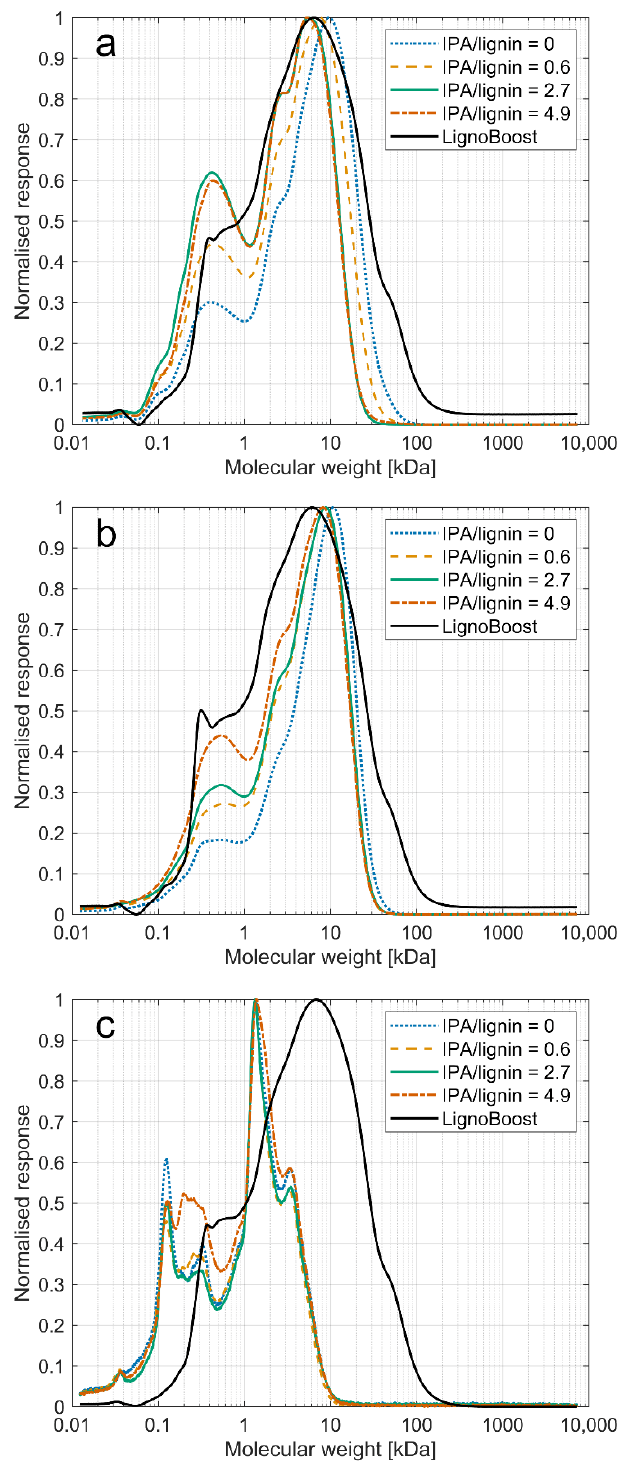
Figure 5. Gel permeation chromatography (GPC) chromatograms in the IPA series: char ( a ), precipitated solids ( b ), and ASO ( c ). These show that, with increasing IPA, the intensity of the low molar mass peak to the left increases for the char and precipitated solids.